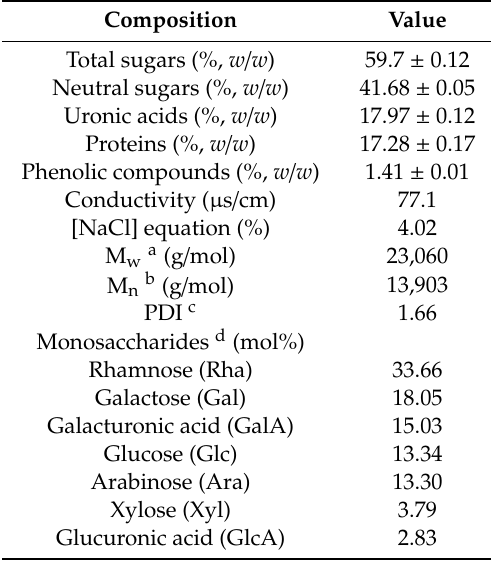
Table 1. Preliminary characterization of NRLP extracted from Nitraria retusa leaves.